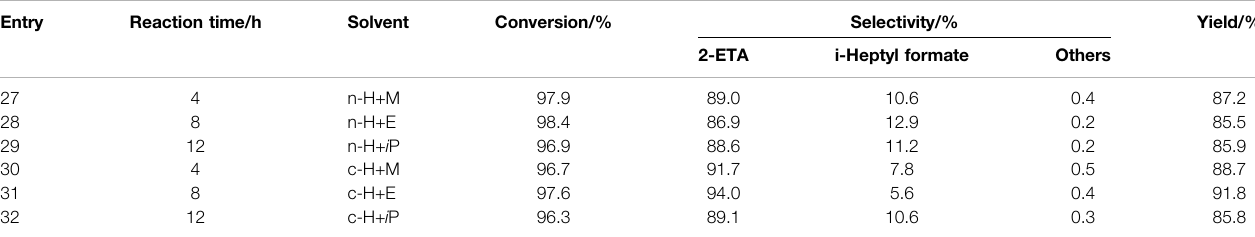
TABLE 4 | Product distribution of reaction endpoint in mixed solvent conditions.